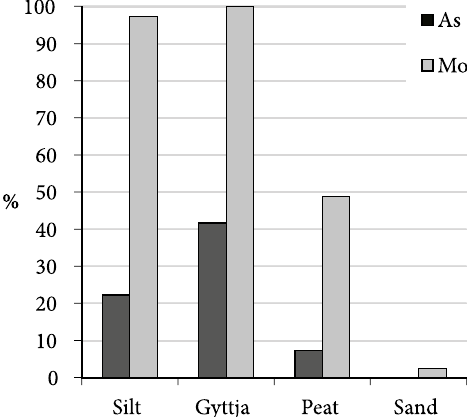
Fig. 4. Percentage of samples where MPC of As and Mo is exceeded in different layers of Netiesos section